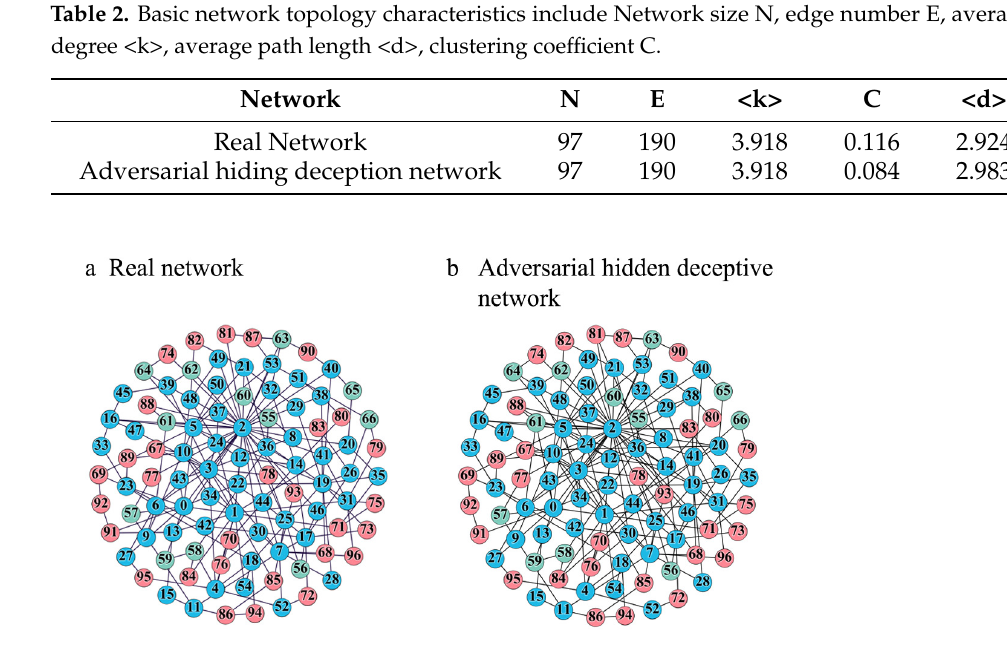
Figure 7. Real network and adversarial hiding deception network. ( a ) is the real network, ( b ) is the adversarial hiding deception network.